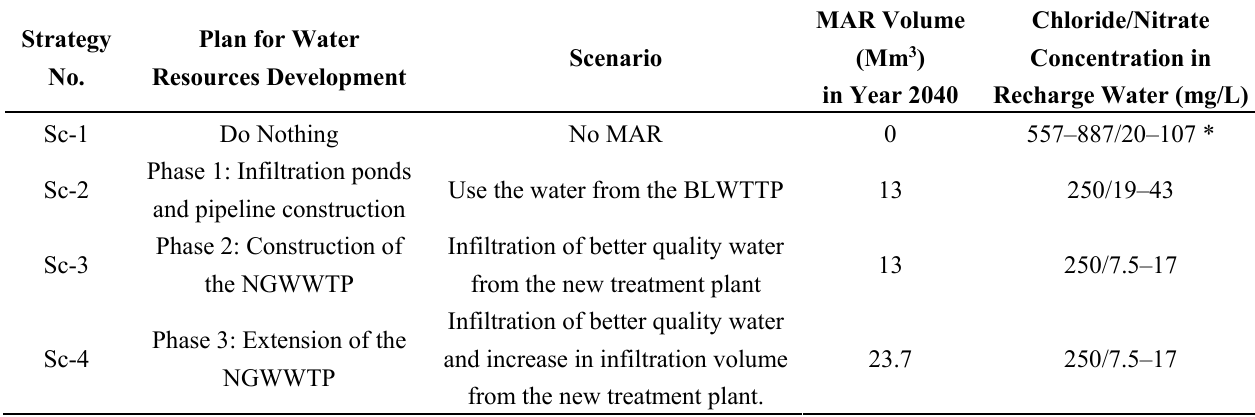
Table 1. MAR management strategies towards the development of water resources at the Northern Gaza